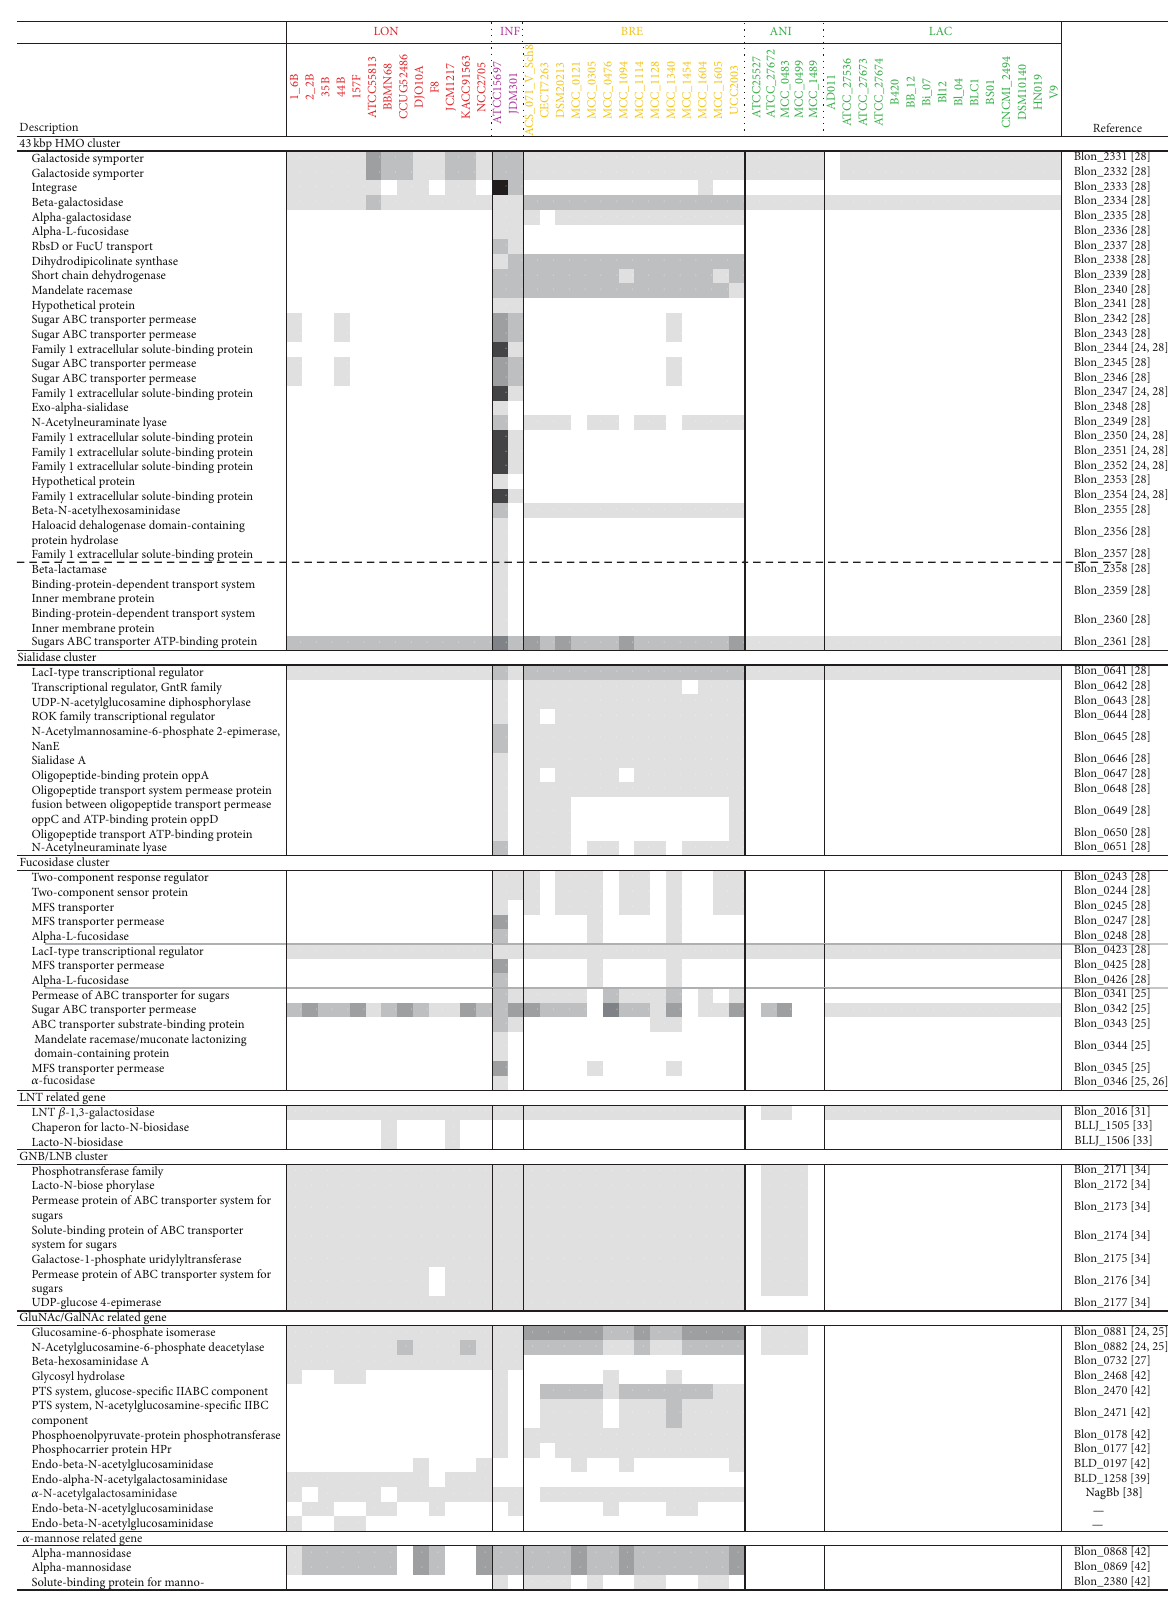
Alpha-mannosidase Solute-binding protein for manno- Figure 2: Distribution of genes involved in the metabolism of host glycans, such as human milk oligosaccharides, mucin, and N-glycans. The abbreviations used for species/subspecies are as follows: INF, B. longum subsp. infantis ; LON, B. longum subsp. longum ; BRE, B. breve ; ANI, B. animalis subsp. animalis ; LAC, B. animalis subsp.